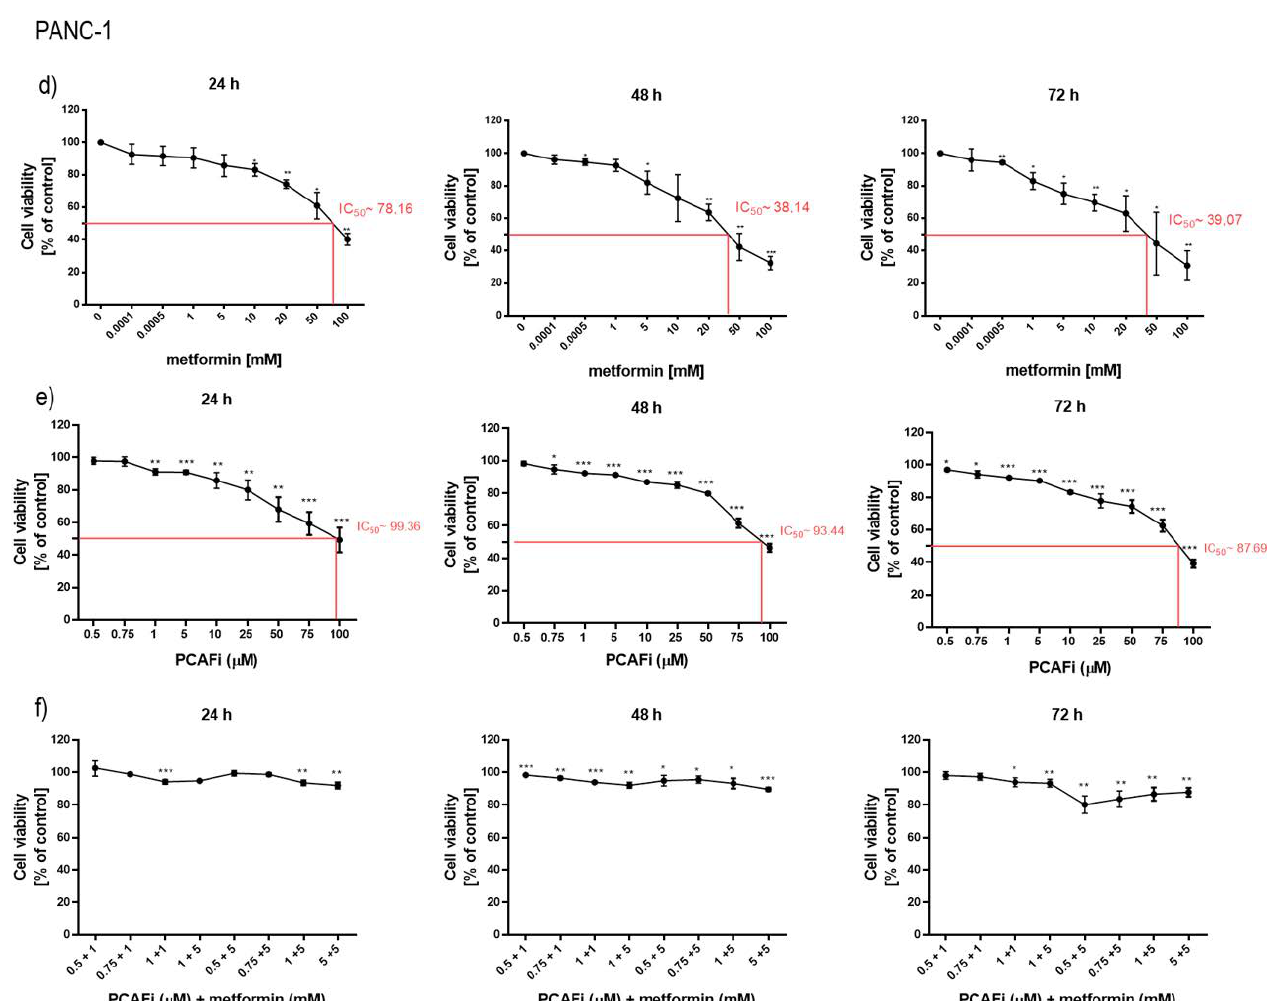
Figure 1. The effect of metformin, HAT inhibitor (HATi), and combination of HATi with metformin on viability of PC cells (( a ) metformin; ( b ) HATi; ( c ) HATi + metformin in 1.2B4; ( d ) metformin; ( e ) HATi; ( f ) HATi + metformin in PANC-1). Cell viability was evaluated by MTT assay. The 1.2B4 and PANC-1 cells were treated with metformin (0.0001–100 mM), HATi (0.5–100 µ M), and HATi (0.5, 0.75, 1, and 5 µ M) with metformin (1 and 5 mM) for 24 h, 48 h, and 72 h. After completion of treatment, MTT was added for 4 h. Then, to dissolve formazan crystals, DMSO was added and absorbance at 570 nm was measured with a microplate reader. The data are presented as the mean ± SD of the results of three independent experiments. * p < 0.05, ** p < 0.01, and *** p < 0.001. 2.5. Metformin Decreases Protein Expression of PCAF in Both 1.2B4 and PANC-1 Cells To assess the effect of metformin on HDAC (SIRT-1) and HAT (PCAF; p300; and CBP) protein expression, a Western blot analysis was performed (Figure